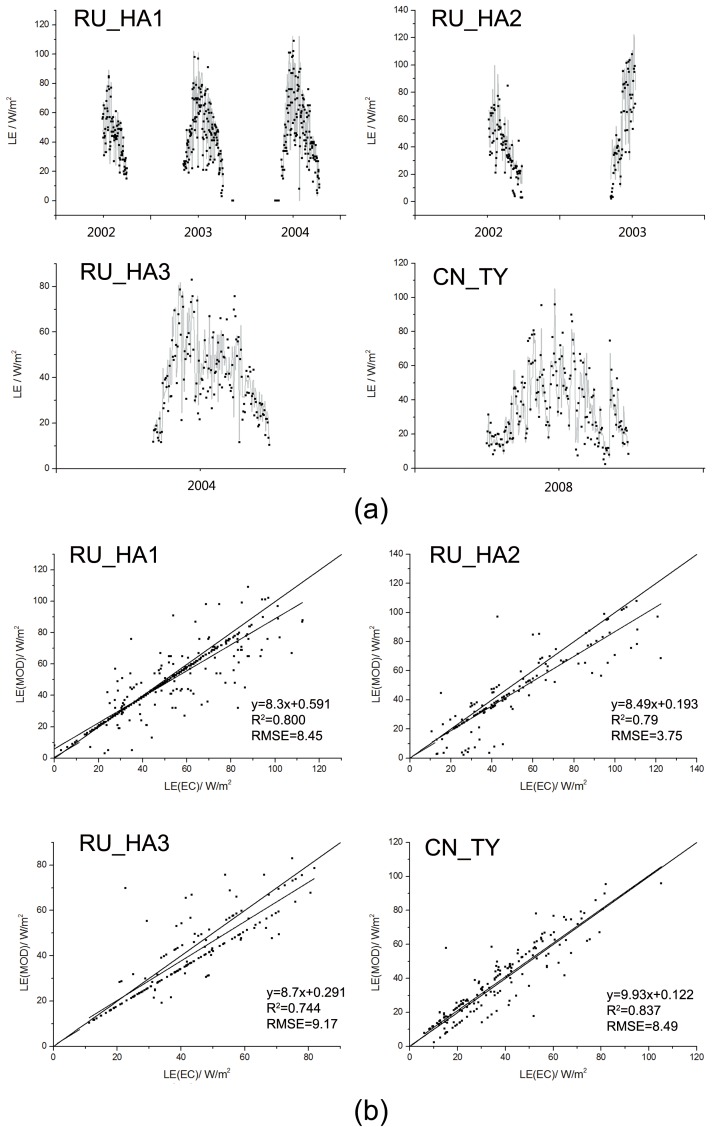
Validation of modeled LE (LEMOD) using the daily eddy covariance data (LEEC) at 4 sites (RU_HA1, RU_HA2, RU_HA3, CN_TY).